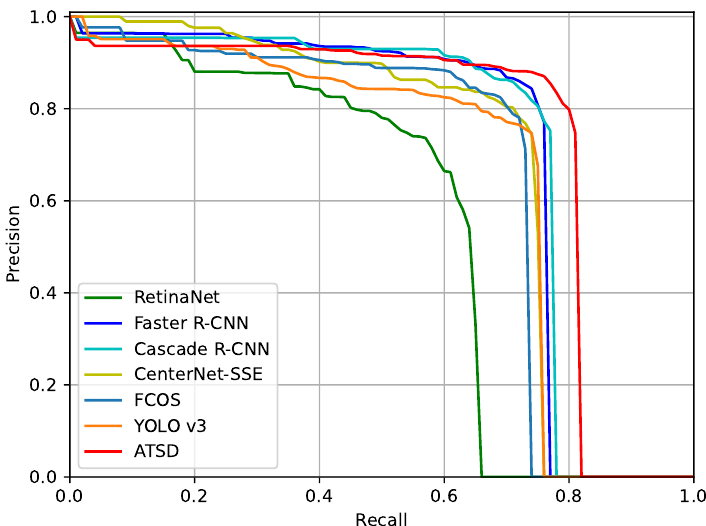
Figure 17. PR curves of different CNN-based methods under the IoU threshold of 0.75 on the SSDD